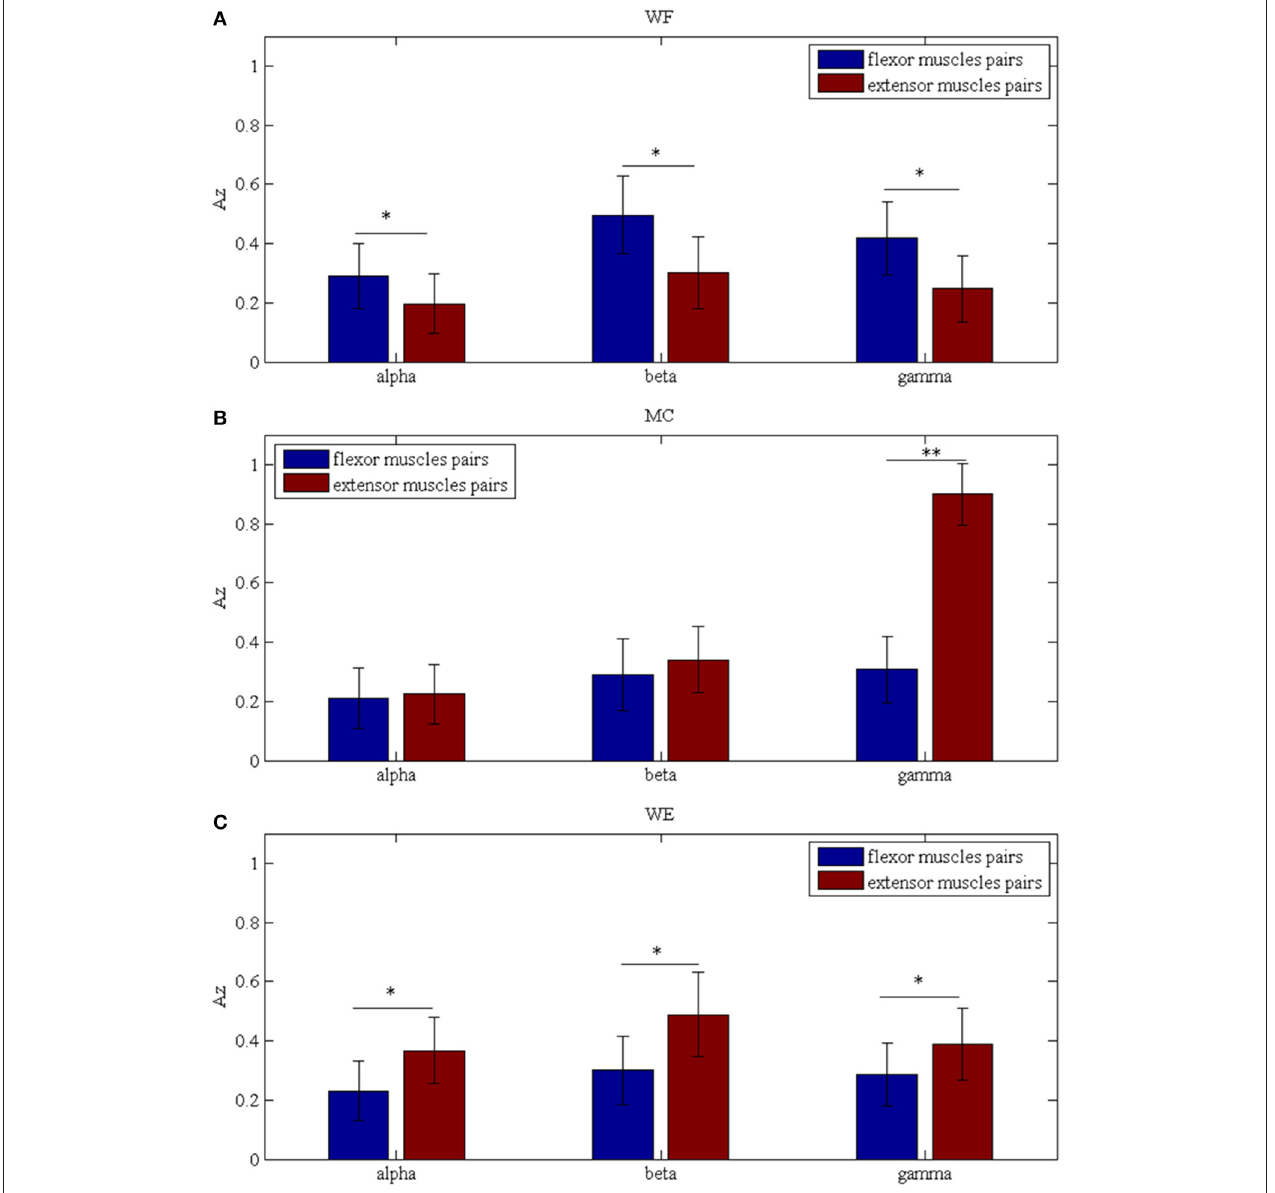
FIGURE 8 | Comparison of the A z values between the flexor and extensor muscle pairs in three bands during (A) WF stage, (B) MC stage, and (C) WE stage, respectively. We denoted the significance with the star mark. * p < 0.05 and ** p <